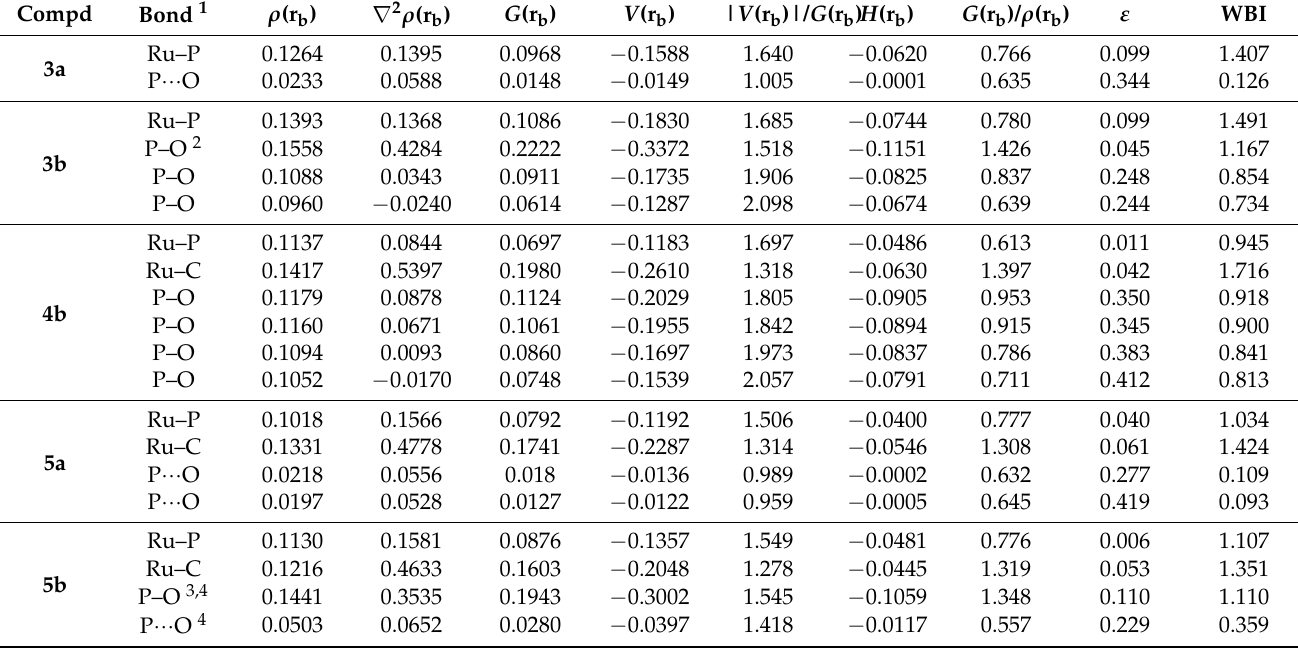
Table 1. Selected features of (3, − 1) critical points in compounds 3a , 3b , 4a , 5a and 5b. Note: